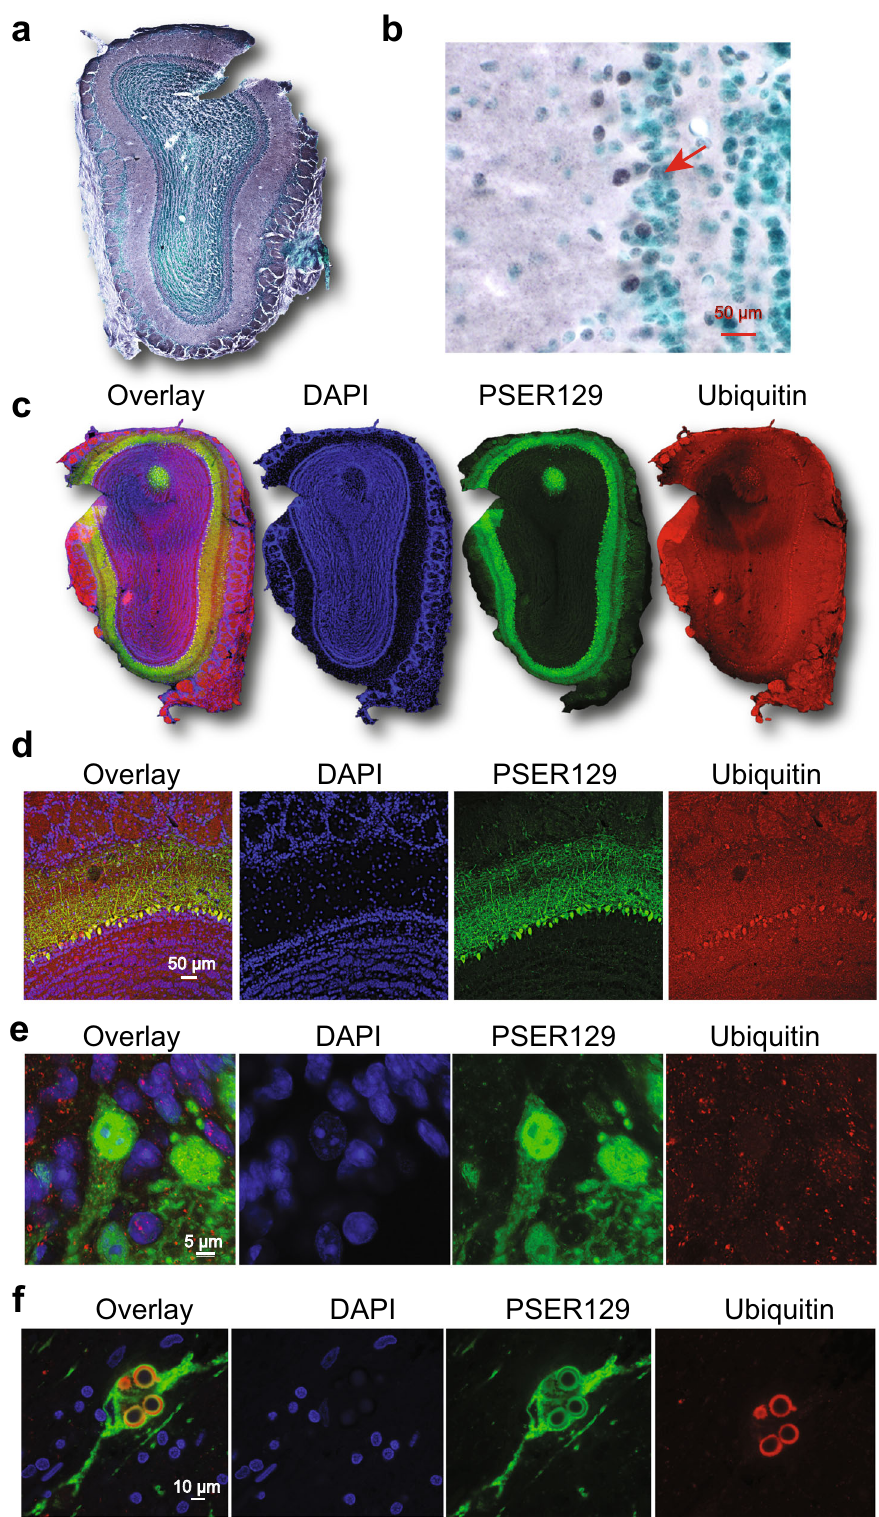
Fig. 5 PSER129 is not associated with ubiquitin in OB mitral cells. Ubiquitin levels and distribution in the mouse OB were determined. a Low magni fi cation image showing ubiquitin staining in the main OB. b High-magni fi cation image showing ubiquitin staining in the mitral cell layer. The red arrow denotes ubiquitin-positive cells in the mitral cell layer. c Low magni fi cation images of OB sections fl uorescently labeled for PSER129 and ubiquitin. d High-resolution confocal images showing the distribution of ubiquitin in the mitral cell layer. e Confocal image of single PSER129 positive mitral cell. f Substantia nigra from PD brain fl uorescently labeled for ubiquitin and PSER129 using the same TSA multiplex approach. All sections were counterstained with either methyl green or DAPI (WT mice n = 3, PD substantia nigra n =